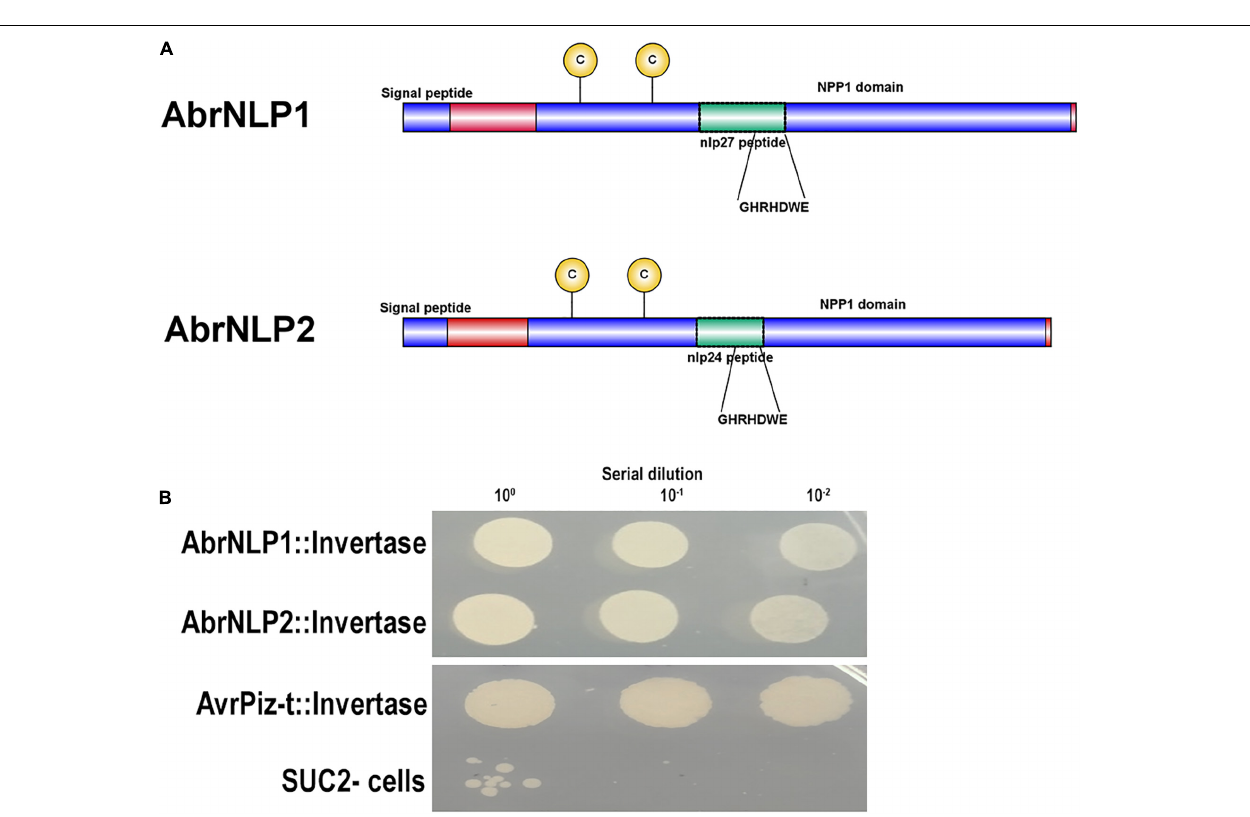
FIGURE 2 | Expression of AbrNLPs during infection of B. juncea . Relative expression analysis of AbrNLP1 and AbrNLP2 in infected B. juncea (natural host) leaves 2 and 4 days post inoculation with respect to plate-grown fungi ( in vitro ). AbrACTIN was used as an endogenous control. The mean values ( ± standard deviation) of three biological replicates are shown. * P < 0.05 by Mann–Whitney U -test.